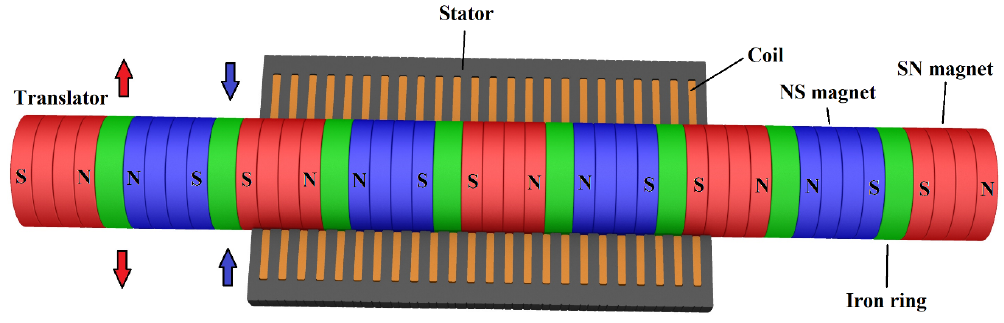
Figure 2. Permanent Magnet generator’s framework.